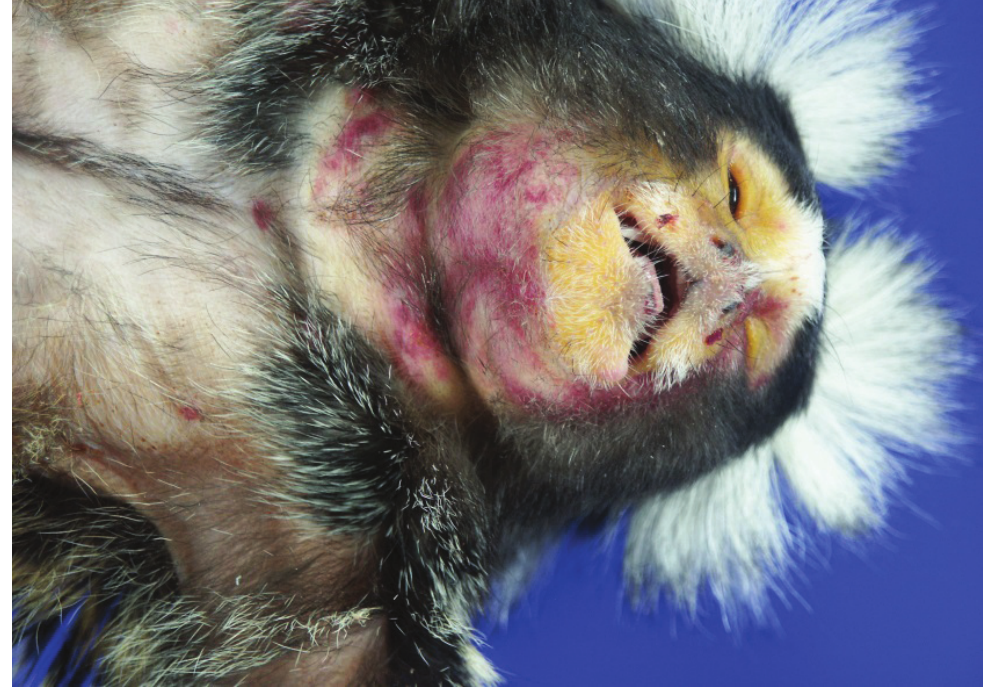
Figure 3. Callithrix jacchus ( C. jacchus ) with marked subcutaneous oedema and erythema on the neck region and single papular lesions on mucocutaneous junctions after experimental infection with calpox.